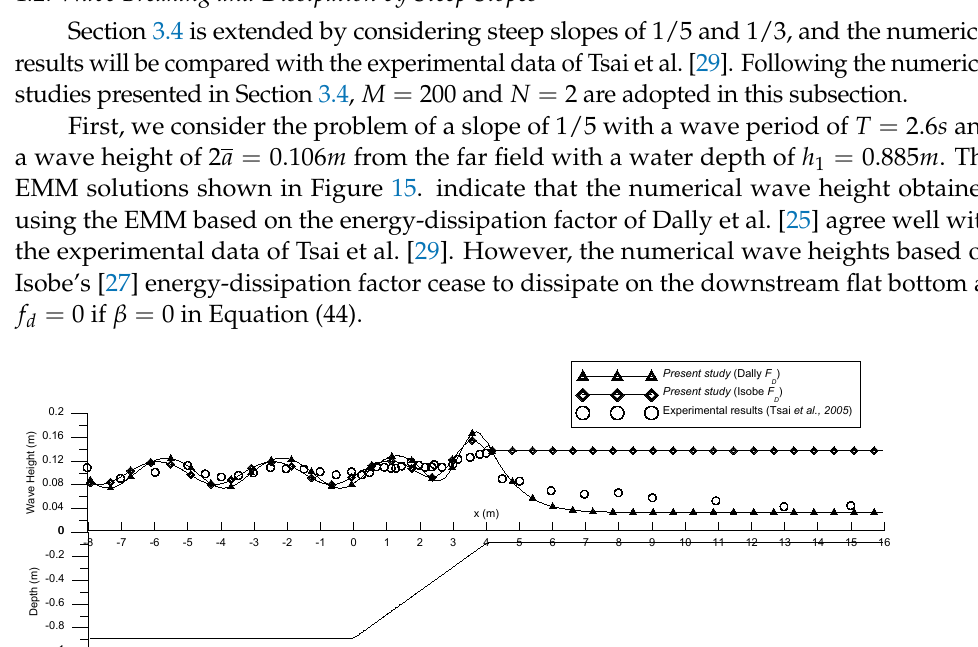
Figure 14. Effects of the breakwater heights on the dimensionless wave force and reflection coefficient.